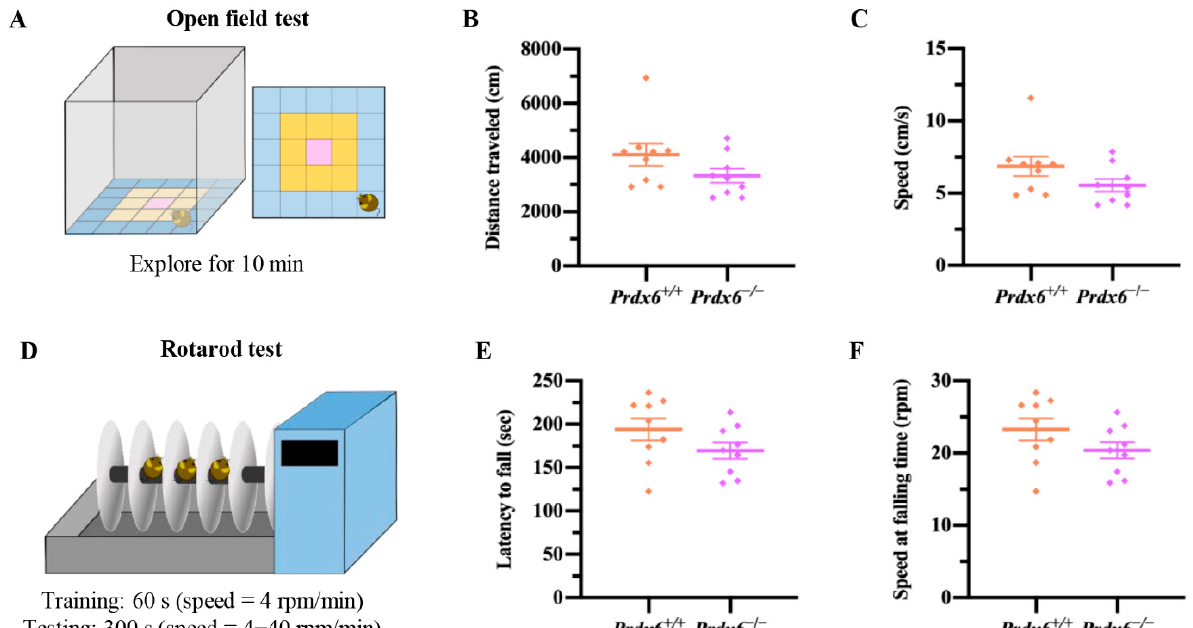
Figure 2. Female Prdx6 − / − mice have normal locomotor functions. ( A ) Schematic diagram of the open field arena. ( B ) The distance traveled and ( C ) moving speed in an open field arena ( Prdx6 +/+ , n = 9 and Prdx6 − / − , n = 9). ( D ) Schematic diagram of the rotarod test protocol. ( E ) Time remaining on an acceleration rotarod (s) before falling. ( F ) Rotational velocity (rpm) at the time of falling. All data are presented as mean ± SEM. PRDX6, peroxiredoxin